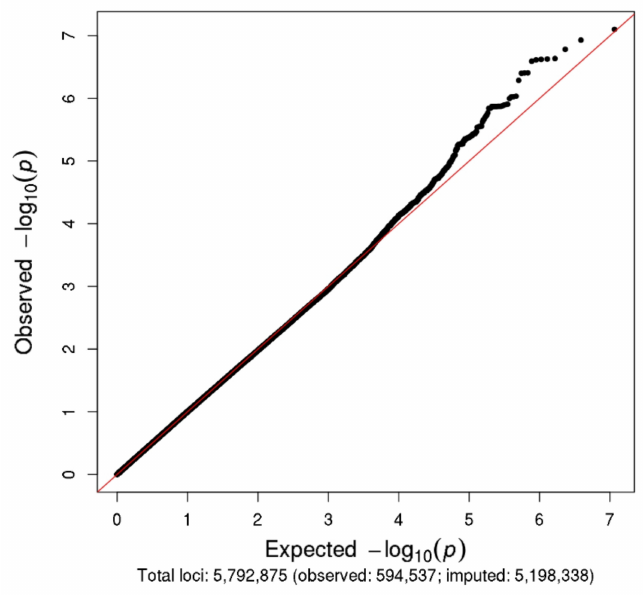
Figure 3. Q–Q plot for N08Cx